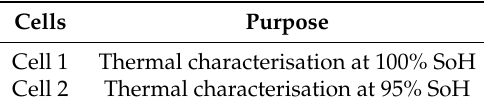
Table 2. Cells testings and